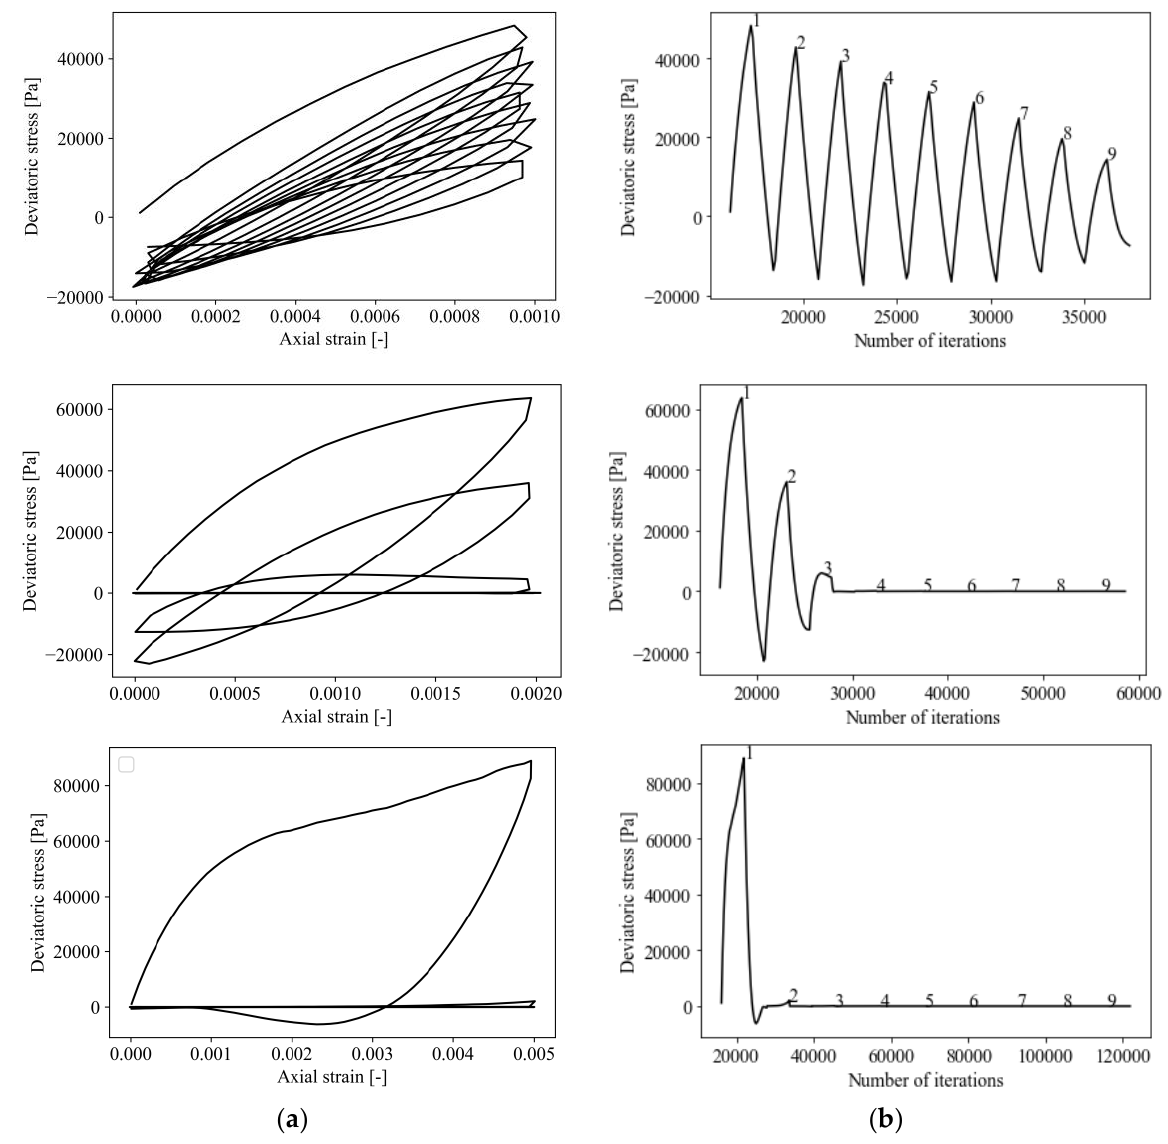
Figure 6. Results of the cyclic triaxial testing for loose sand: ( a ) deviatoric stress–strain hysteresis curves; ( b ) evolution of the deviatoric stress with the increase of the number of cycles.